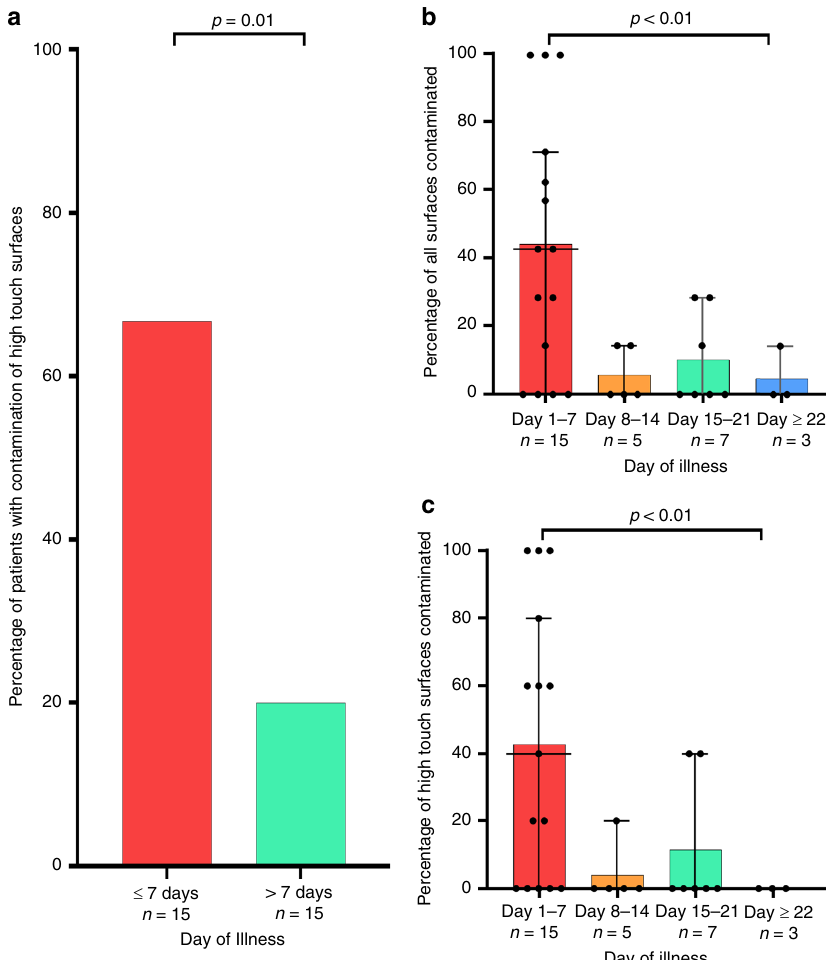
Fig. 2 Extent of environmental contamination correlated with day of illness timepoint. a Percentage of patients with contamination of high-touch surfaces in the fi rst week of illness compared with more than fi rst week of illness, n = 15 in both groups. b Percentage of surfaces contaminated across weeks of illness with median and 95% con fi dence intervals. c . Percentage of high-touch surfaces contaminated across weeks of illness with median and 95% con fi dence